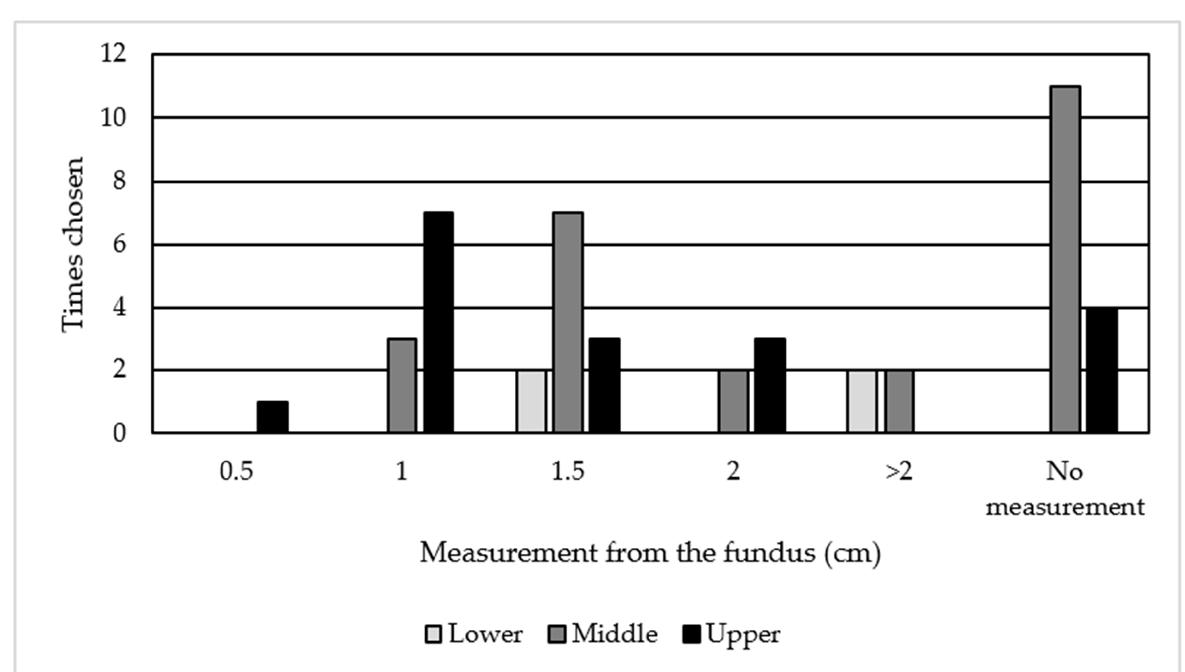
Figure 4. Units’ interpretation on distance from fundus to location in uterine cavity.